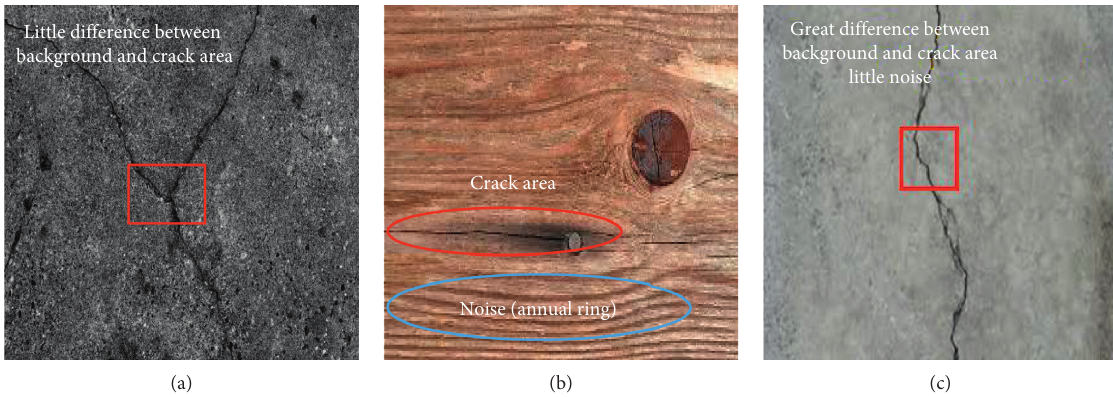
Figure 1: Cracks on different types of surfaces: (a) asphalt pavement; (b) timber; (c)